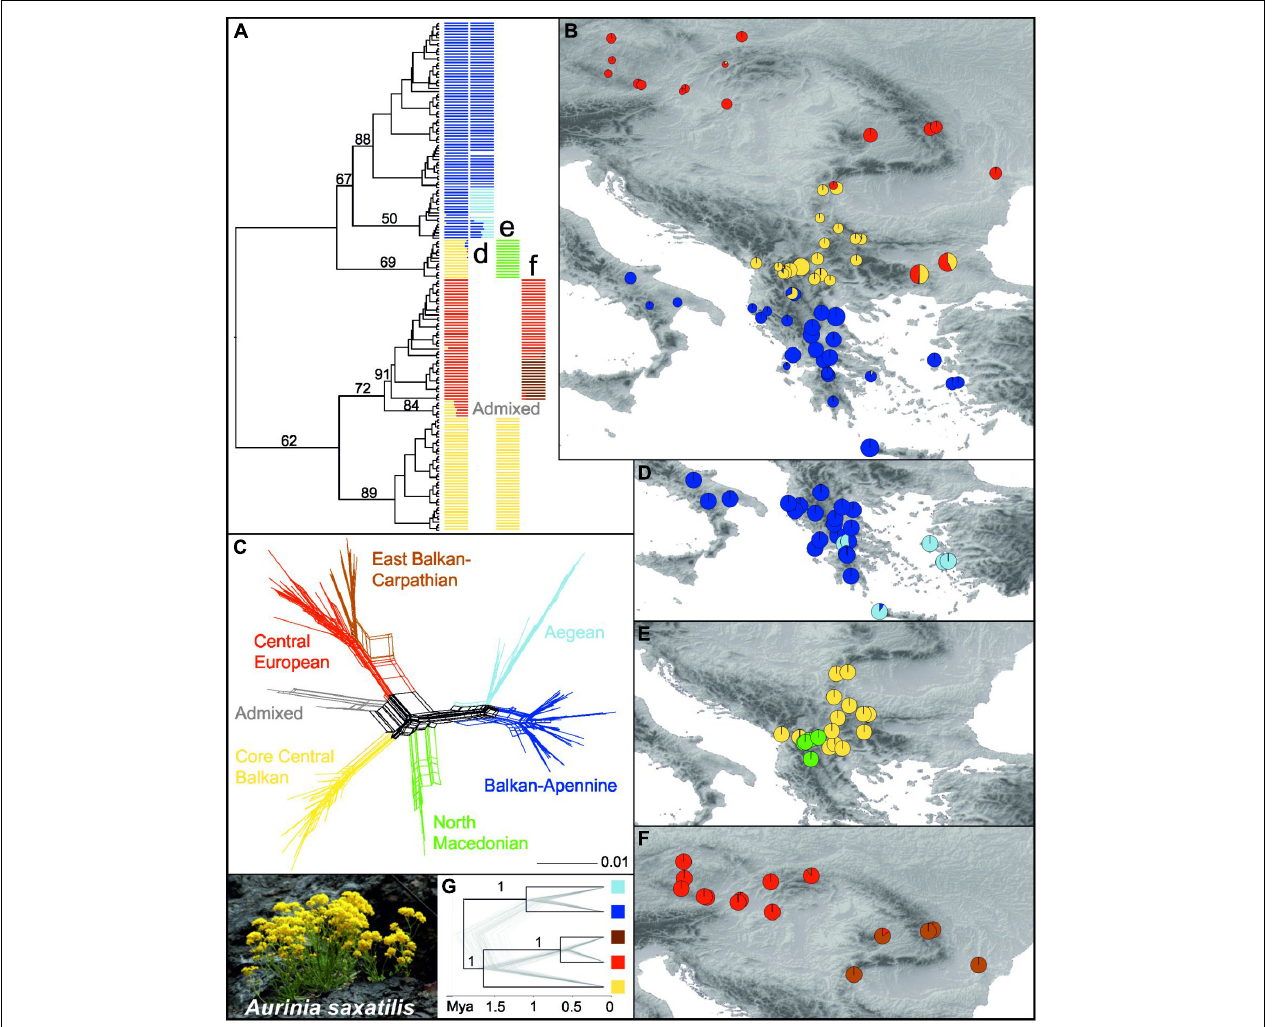
FIGURE 2 | Genetic structure in Aurinia saxatilis (photo by I. Rešetnik in the bottom left corner) based on restriction site-associated DNA sequencing (RADseq). (A) Simplified maximum likelihood tree as shown in Supplementary Figure 6 , without outgroup and with bootstrap support of major clades above branches. The tree is complemented with barplot representations of the three main fastSTRUCTURE groups shown in (B) and their subgroups shown in (D–F) . In (B) , sizes of the pie charts reflect the number of private alleles in each population. (C) NeighborNet based on Hamming distances. (G) Simplified SNAPP analysis species tree with bootstrap support of major clades above branches, as shown in Supplementary Figure 9 .